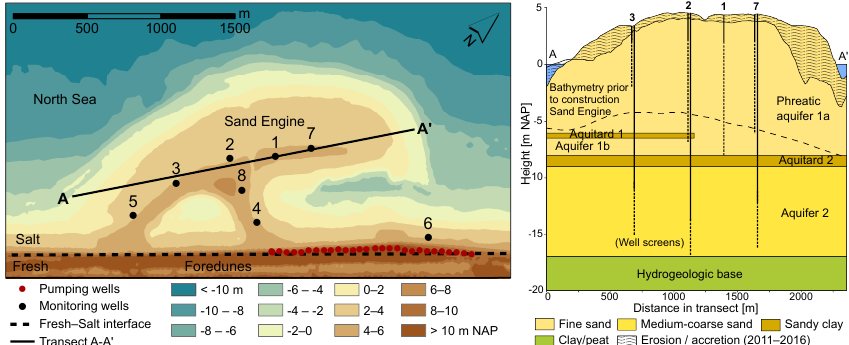
Figure 2. Contour map of topographic height (in metres with respect to the NAP datum) and hydrogeological cross section (along black line, A–A’) of the Sand Engine between 1 and 3 August 2011, with the location of monitoring wells (black points) and pumping wells (red points). The dashed line in the cross section marks the bathymetry prior to the construction of the Sand Engine, and the wave-shading pattern marks the erosion or accretion of sand between 3 August 2011 and 3 June